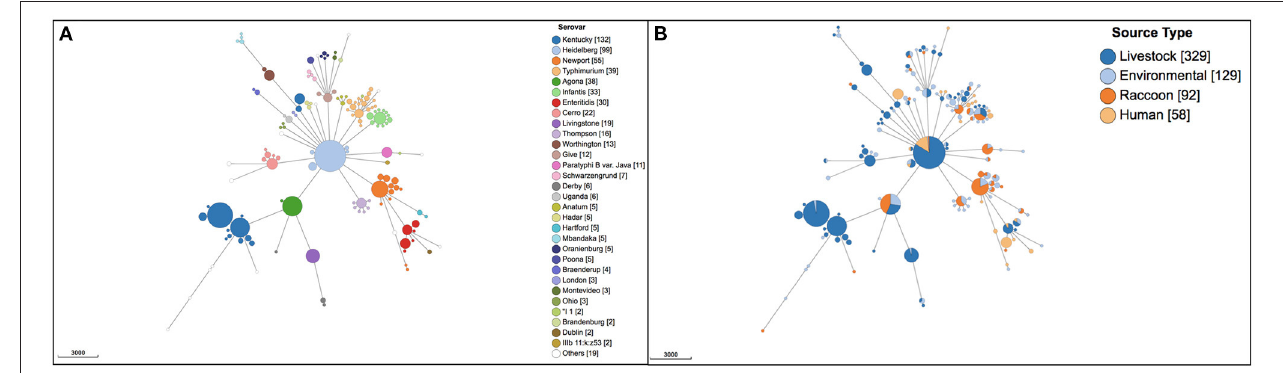
FIGURE 1 | Population structure of 608 Salmonella enterica isolates from raccoons, livestock, humans, and environmental sources in southern Ontario, Canada based on 3002-loci cgMLST scheme from Enterobase. Minimum spanning tree created using k = 30 clustering threshold in GrapeTree . (A) Distribution of 45 serovars determined using SISTR. (B) Distribution of source types. Frequency counts are in square brackets. Bubble size is proportional to the number of isolates in each cluster, and each cluster contains isolates differing at a maximum of 30 cgMLST